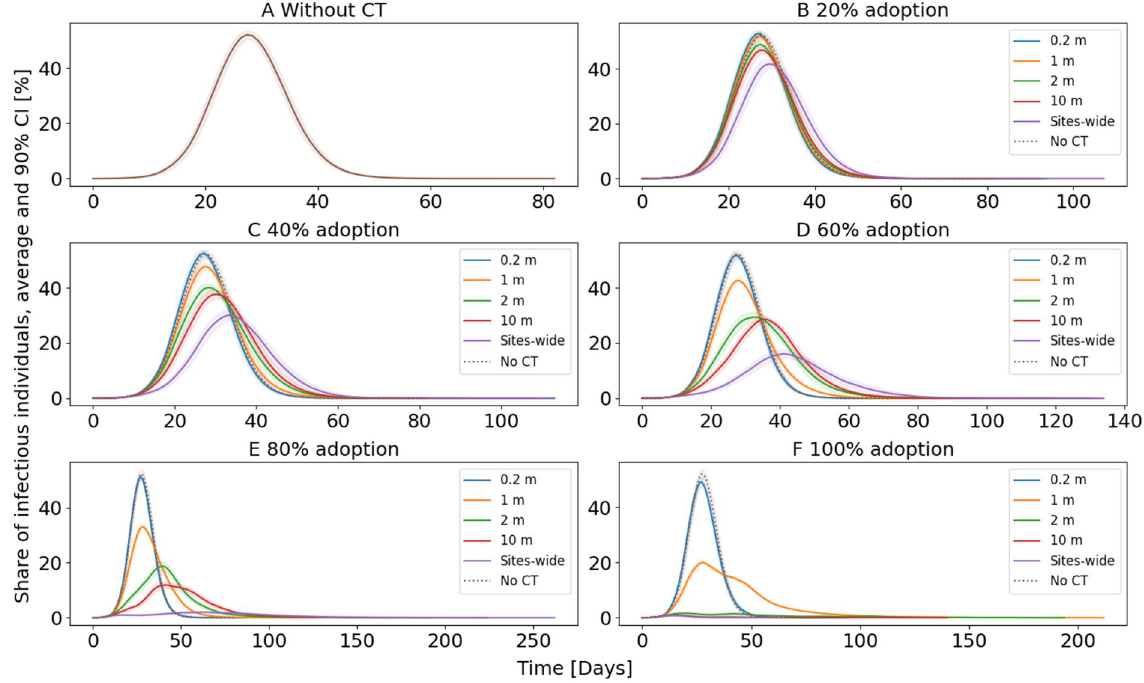
Figure 1. Average share of infectious individuals. For each curve, the mean from 30 simulations, and the 90% confidence intervals (displayed as colored shades behind each curve) are plotted. The characteristics of the individual curves depend highly on the PDR and the adoption rate.